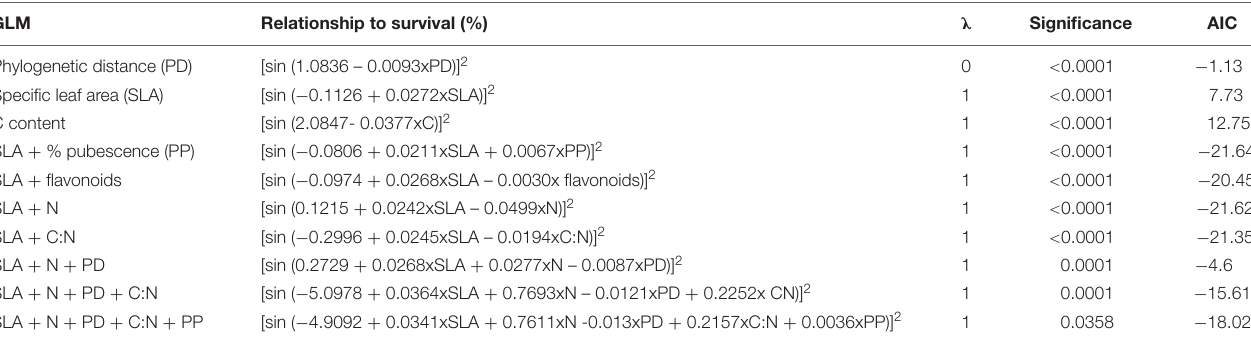
Lower Akaike Information Criterion (AIC) values indicate a closer fit to the data. Survival values were arc-sine square-root transformed. Phylogenetic signal associated with the regression was estimated with λ (values near 1 indicate strong phylogenetic signal of the residuals, values near 0 indicate null or weak phylogenetic signal).